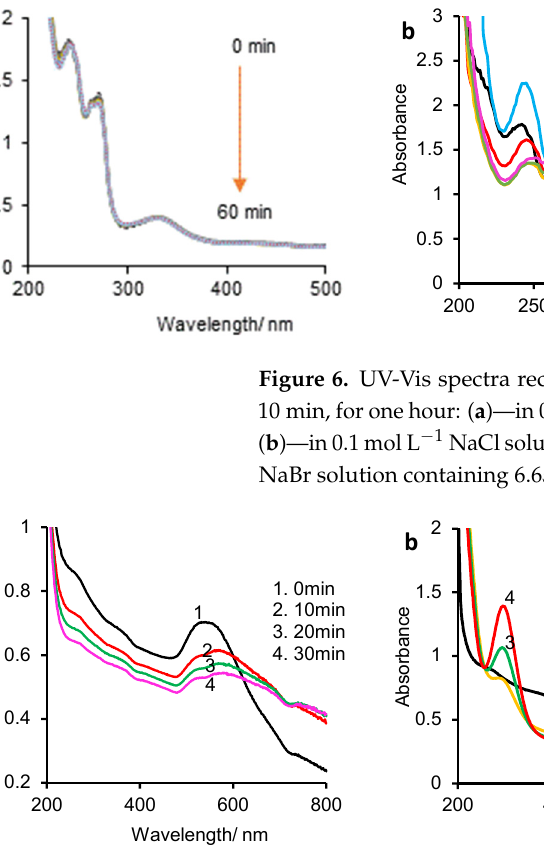
Figure 8. UV-Vis spectra recorded before and during constant current density electrolysis: ( a )—in 0.1 mol L − 1 NaF solution containing 6.65 × 10 − 5 mol·L − 1 VK and 75 mg·L − 1 AuNPs (NaF–VK–AuNPs); ( b )—in 0.1 mol L − 1 NaCl solution containing 6.65 × 10 − 5 mol·L − 1 VK and 75 mg·L − 1 AuNPs (NaCl– VK–AuNPs), every minute—from initial time to five minutes; ( c )—in 0.1 mol L − 1 NaCl solution containing 6.65 × 10 − 5 mol·L − 1 VK and 75 mg·L − 1 AuNPs (NaCl–VK–AuNPs), every 10 min—from initial time to 60 min; ( d )—in 0.1 mol L − 1 NaBr solution containing 6.65 × 10 − 5 mol·L − 1 VK and 75 mg·L − 1 AuNPs (NaBr–VK–AuNPs), every 10 min—from initial time to 30 min. 3.3.1. Degradation of VK over Time in NaX Solutions The UV-Vis spectra recorded in NaX–VK solutions, time one hour, are represented in Figure 6. Throughout the electrolysis, vitamin K is stable, and in the presence of F − ions, the spectra collected during the electrolysis are superimposed over the initial one (Figure 6a) and are unstable in the presence of Cl − (Figure 6b) and Br − ions (Figure 6c). As shown in Figure 6b, in the NaCl–VK solution, after 30 min, the characteristics of the VK spectrum in the presence of Cl − ions are changed, by the appearance of the peak